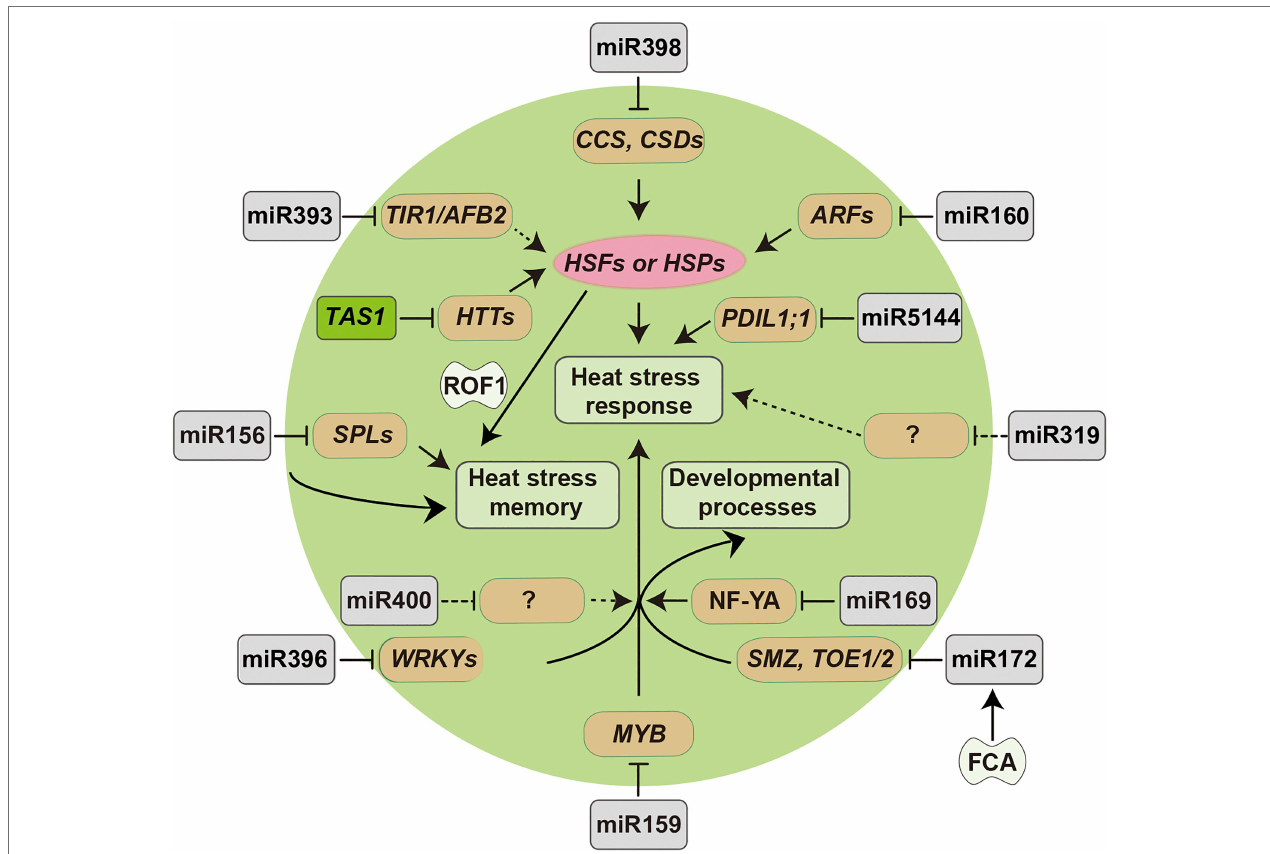
FIGURE 2 | Diagram of miRNA-target modules involved in plant responses to heat stress. Arrowed lines represent promotional effects and flat lines represent repressive effects. Dashed lines indicate hypotheses that need to be